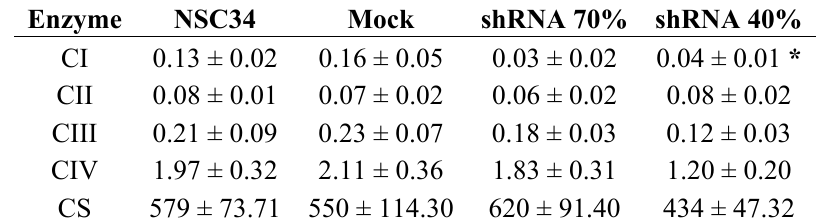
Table 1. Effect of frataxin silencing on mitochondrial electron transport complex activities.